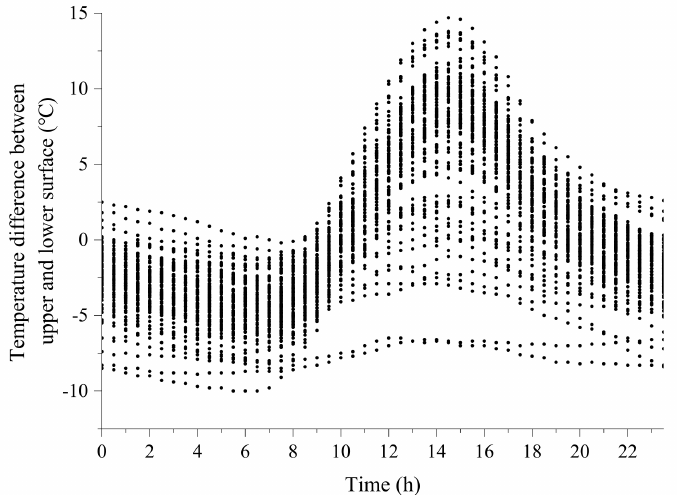
Figure 5. Diurnal variation of temperature difference between upper and lower surface of ballast- less